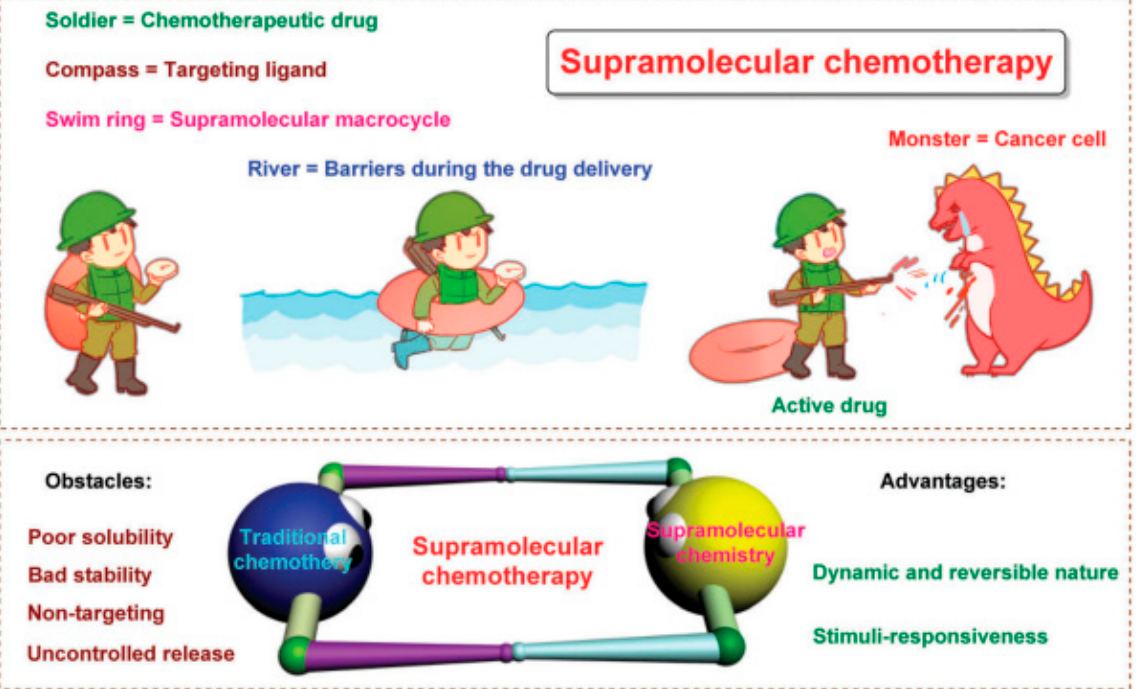
Figure 3. PDT and chemotherapy. Schematic diagram of supramolecular chemotherapy. Below is: Schematic diagram of supramolecular chemotherapy combining conventional chemotherapy and supramolecular chemistry. The obstacles to the clinical application of conventional chemotherapy and the advantages of supramolecular chemistry are pointed out. Reproduced with permission from Ref. [44], Copyright (2017) Royal Society of Chemistry .